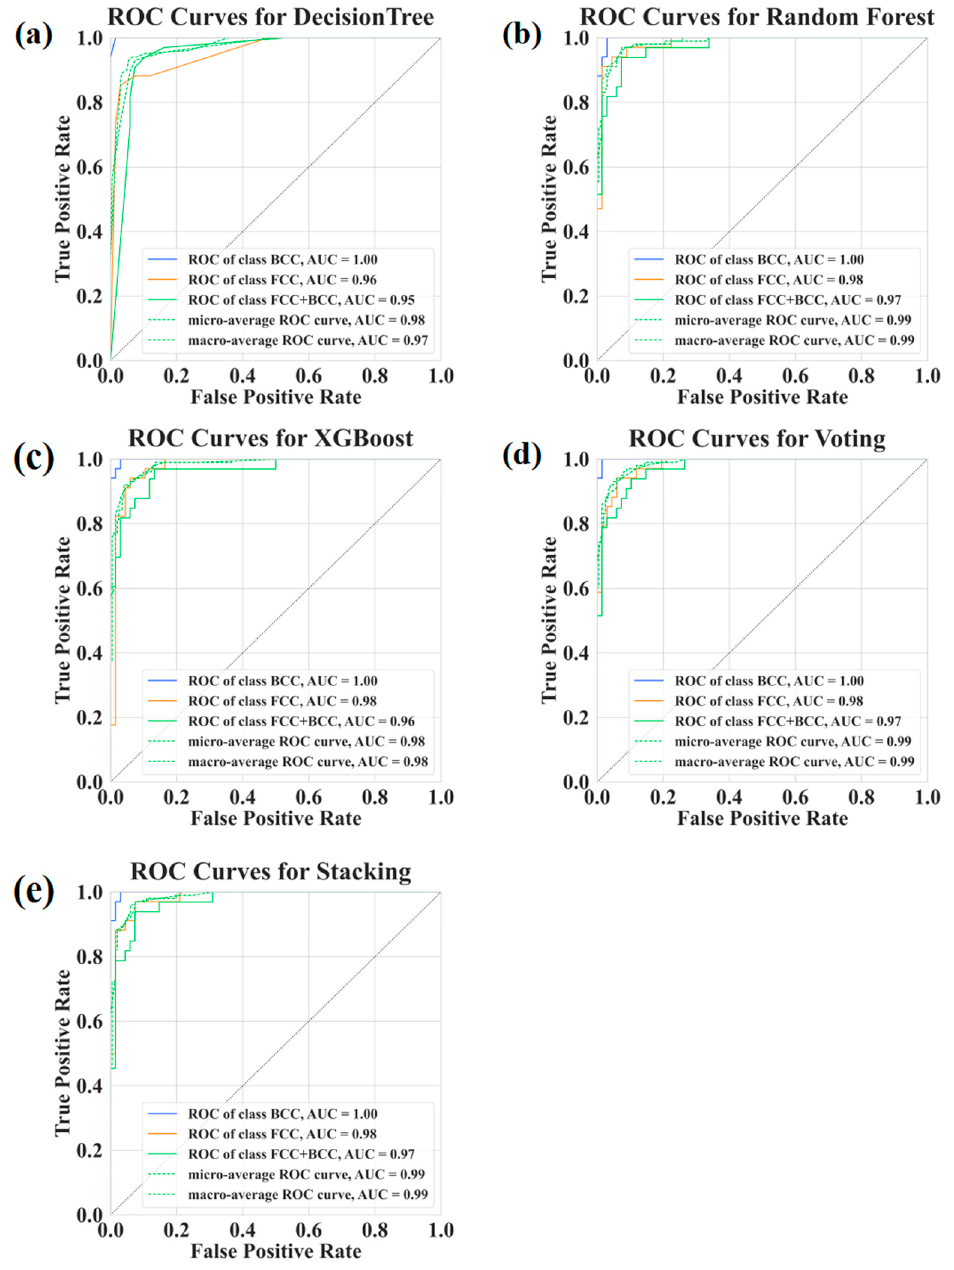
Figure 6. Visualization metrics for the 5 classifiers: ( a ) ROC-curve of Decision Tree, ( b ) ROC-curve of Random Forest, ( c ) ROC-curve of XGBoost, ( d ) ROC-curve of Voting, and ( e ) ROC-curve of Stack- ing.